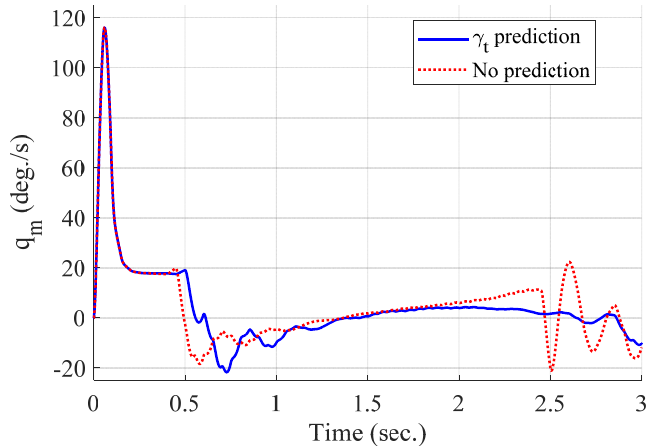
Figure 11. Pitch rate of the missile (single-run